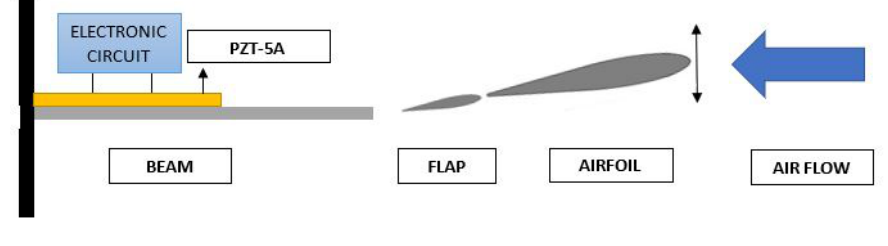
Figure 10. Aeroelastic energy harvester model [149]. A 3-DOF airfoil is constrained with flap motion and is subjected to the airfoil supported elastically by linear plunge and linear torsional